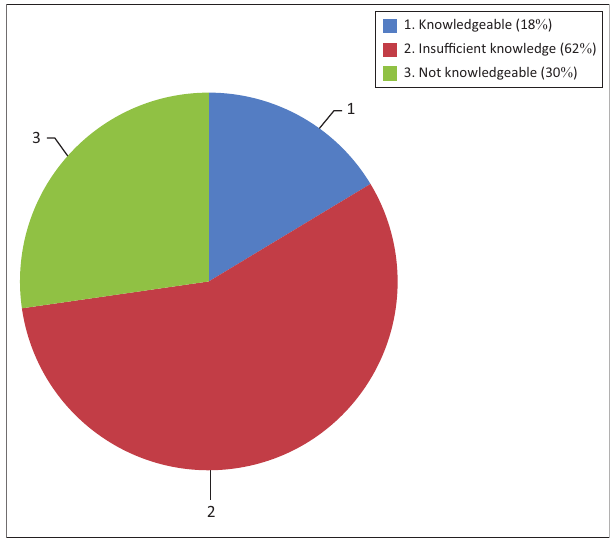
FIGURE 1: Participants’ knowledge of occupational legislation ( n = 110).